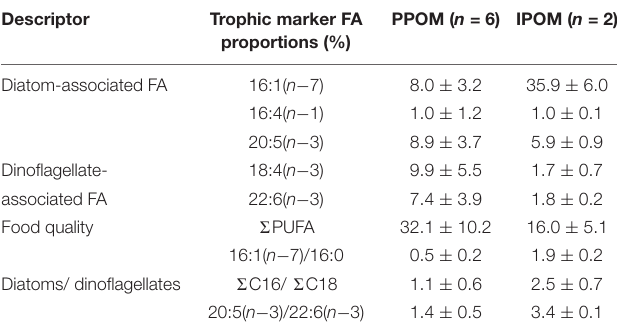
TABLE 2 | Relative proportions of trophic marker fatty acids (FAs; mean ± SD%) and FA ratios (mean ± SD) in pelagic particulate organic matter (PPOM) and ice-associated POM (IPOM) collected during Nansen Legacy cruise Q3 in August 2019 in the Barents